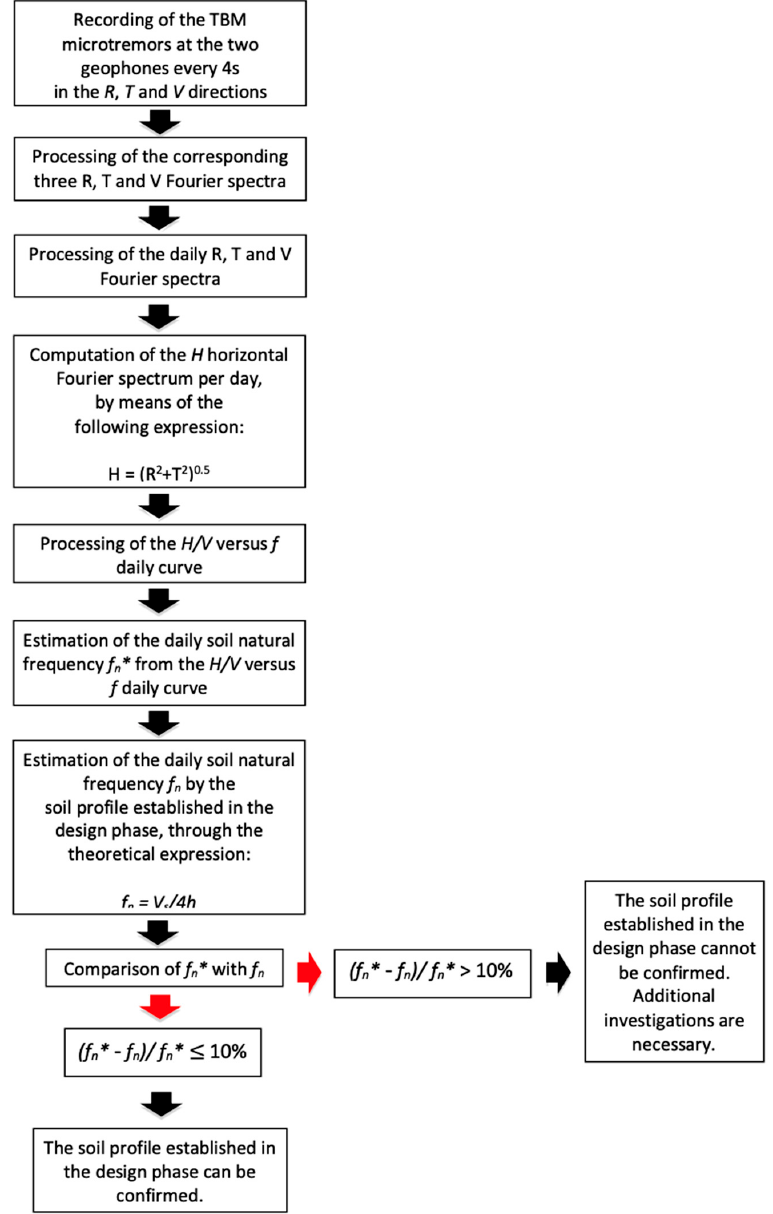
Figure 5. Flow chart of the proposed procedure ( f n is the natural frequency obtained by the well- known theoretical expression f n = V s/4 h ; f n * is the natural frequency estimated by the H / V vs. f curve).